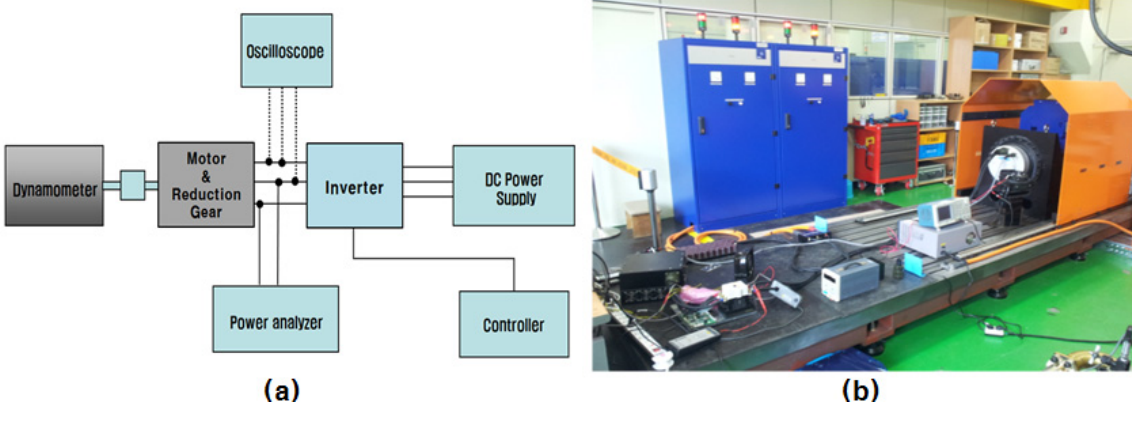
Figure 1. Experimental apparatus for measuring motor characteristics: ( a ) block diagram of the test bench for measuring motor characteristics; ( b ) photo of experimental